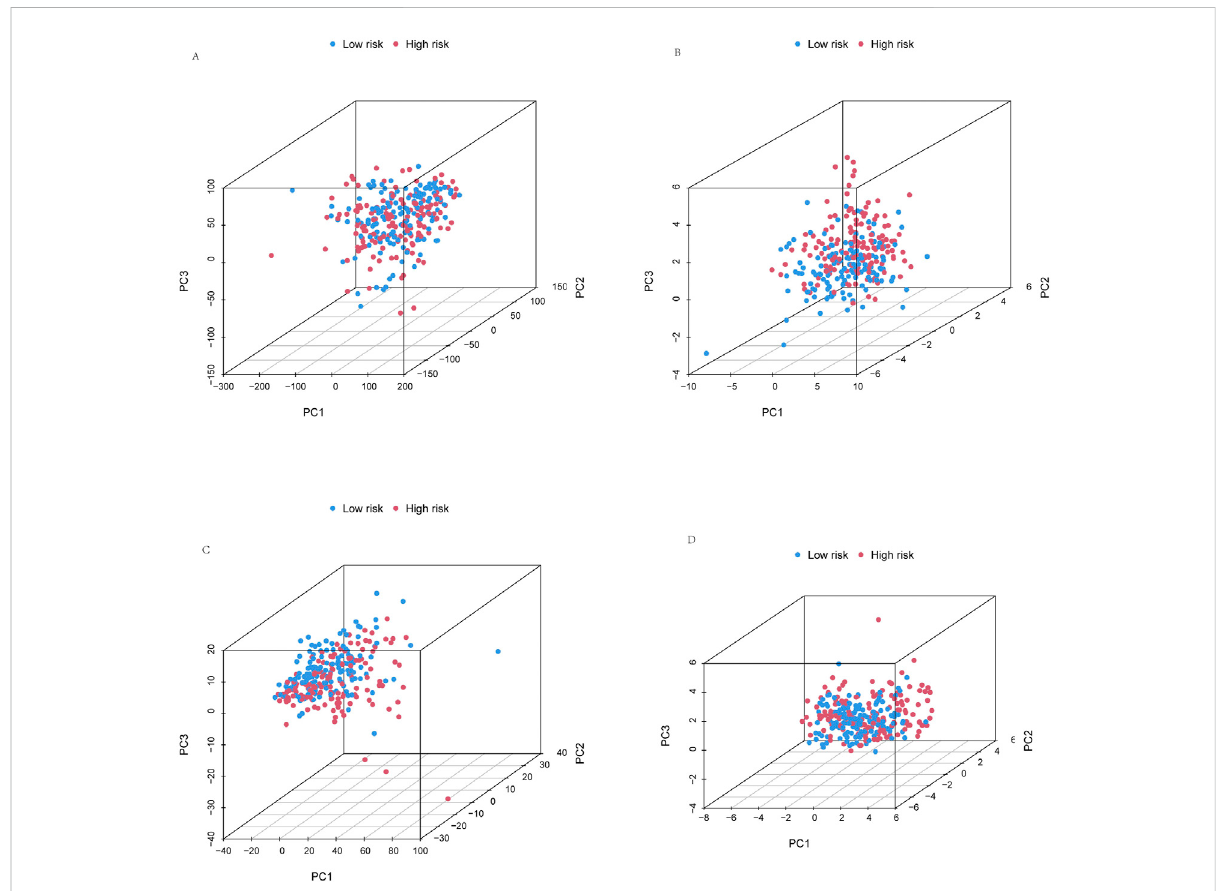
FIGURE 7 Principal component analysis. PCA observed the distribution of patients according to (A) all genes. (B) Cuproptosis-related genes. (C) Cuproptosis-relatedlncRNAs. (D) RisklncRNAs.Patientswithhigh-riskscoresaredenotedinred,whilethosewithlow-riskscoresarerepresentedin